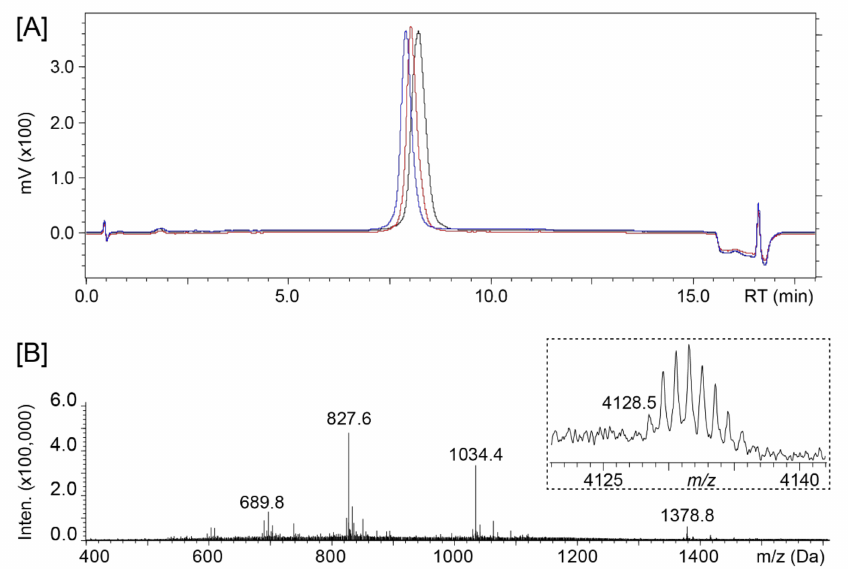
Figure 3. Characterization of [L6-optP7]Mco. ( A ) Analytical HPLC traces of the three pure fractions (f4–f6) and ( B ) ESI-MS spectrum of main fraction f6 showing [M + H] +3 , [M + H] +4 , [M + H] +5 , and [M + H] +6 ions. MALDI insert shows the monoisotopic mass corresponding to the fully oxidized and backbone cyclized peptide.